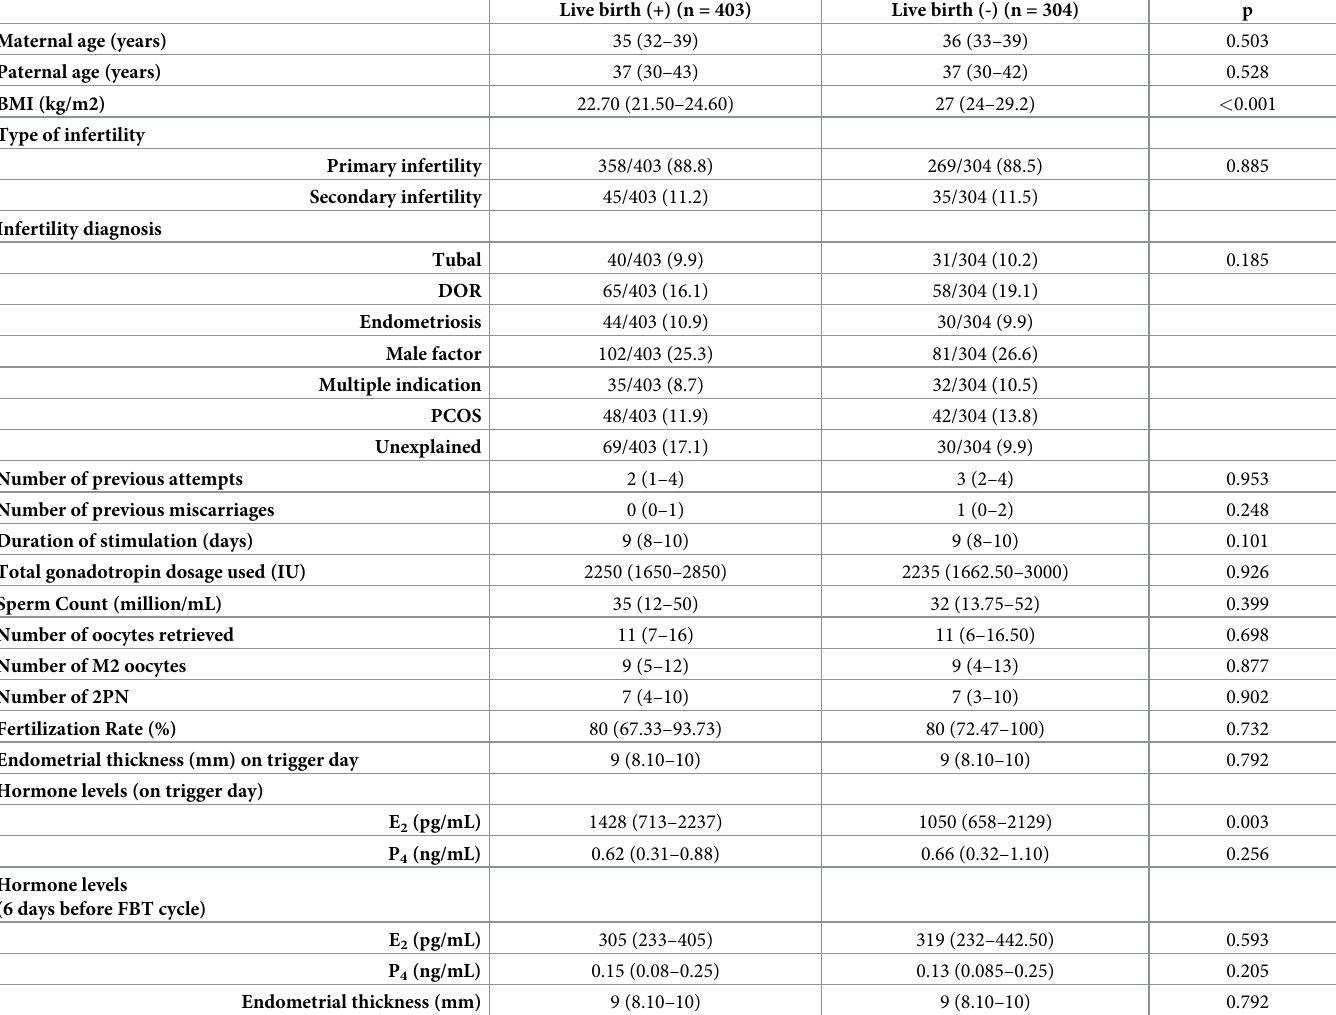
Table 2. Patient characteristics, ovarian stimulation variables and variables during the FBT cycles in comparison with patients with or without live birth. Live birth (+) (n =